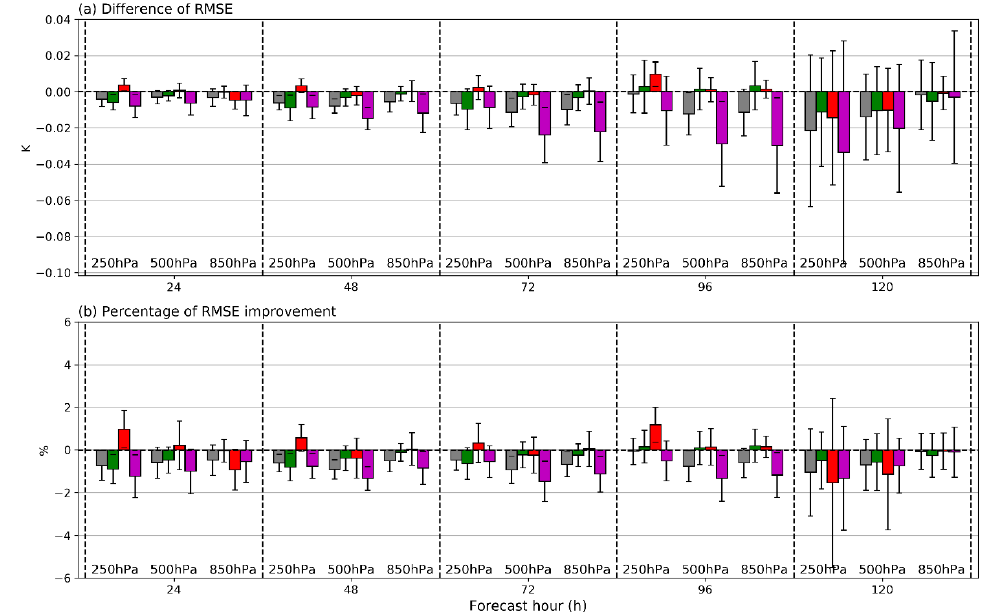
Figure 11. The ( a ) mean and ( b ) normalized difference of RMSE of 250 hPa, 500 hPa, and 850 hPa temperature forecast up to 120–h forecast hours between the latency_20m and control runs. Grey, green, red, and magenta boxes indicate the results over the Global, Northern Hemisphere, Tropic, and Southern Hemispheres, respectively. Vertical bars representing 95% confidence level of the uncertainty are overlaid.